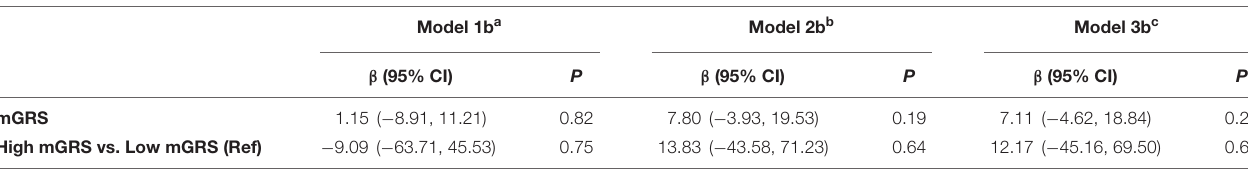
TABLE 3 | Association of maternal obesity genetic risk with birthweight.